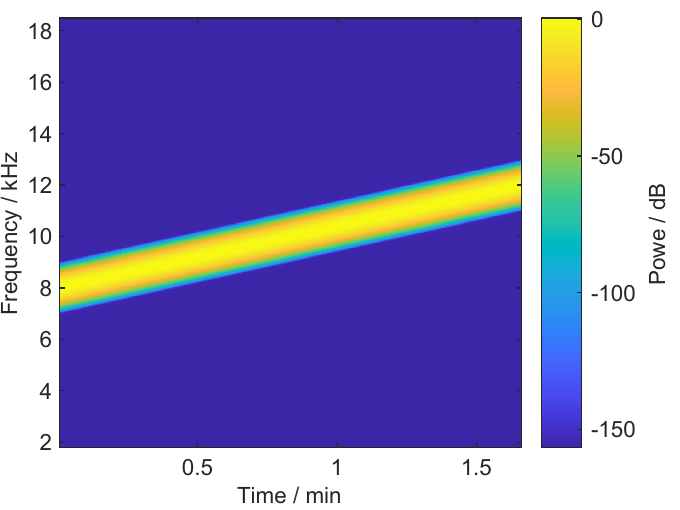
Figure 6. The time-frequency spectrogram of a chirp signal with parameters defined in Table 2.